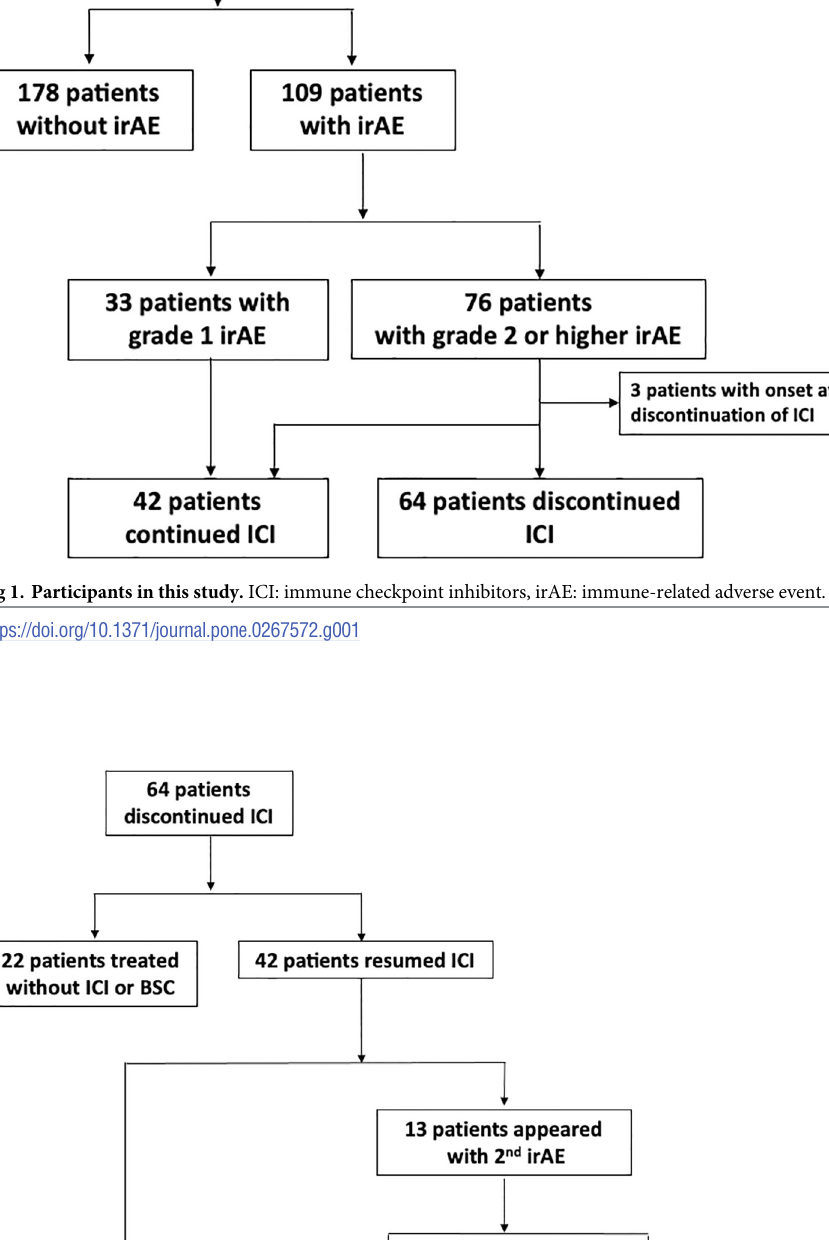
PLOS ONE | https://doi.org/10.1371/journal.pone.0267572 April 28,